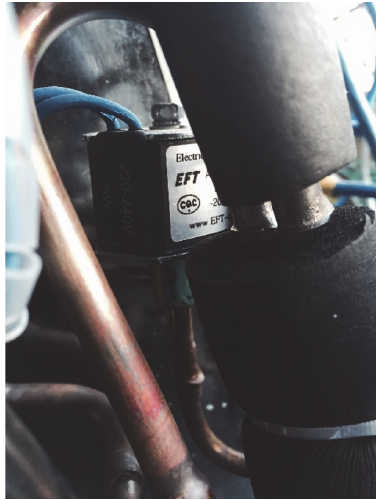
Figure 14: Electromagnetic valve photo adopted in ice maker